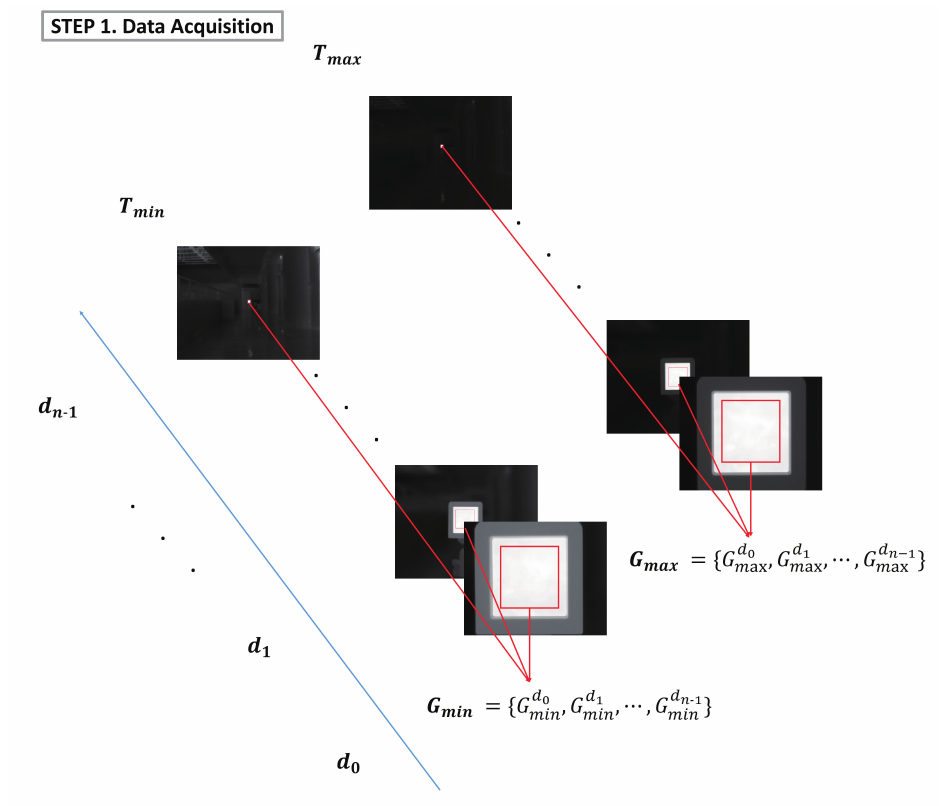
Figure 6. [STEP 1: Data Acquisition] Obtain G min and G max by measuring T min and T max for each distance and calculate T min − T max radiation through Planck’s